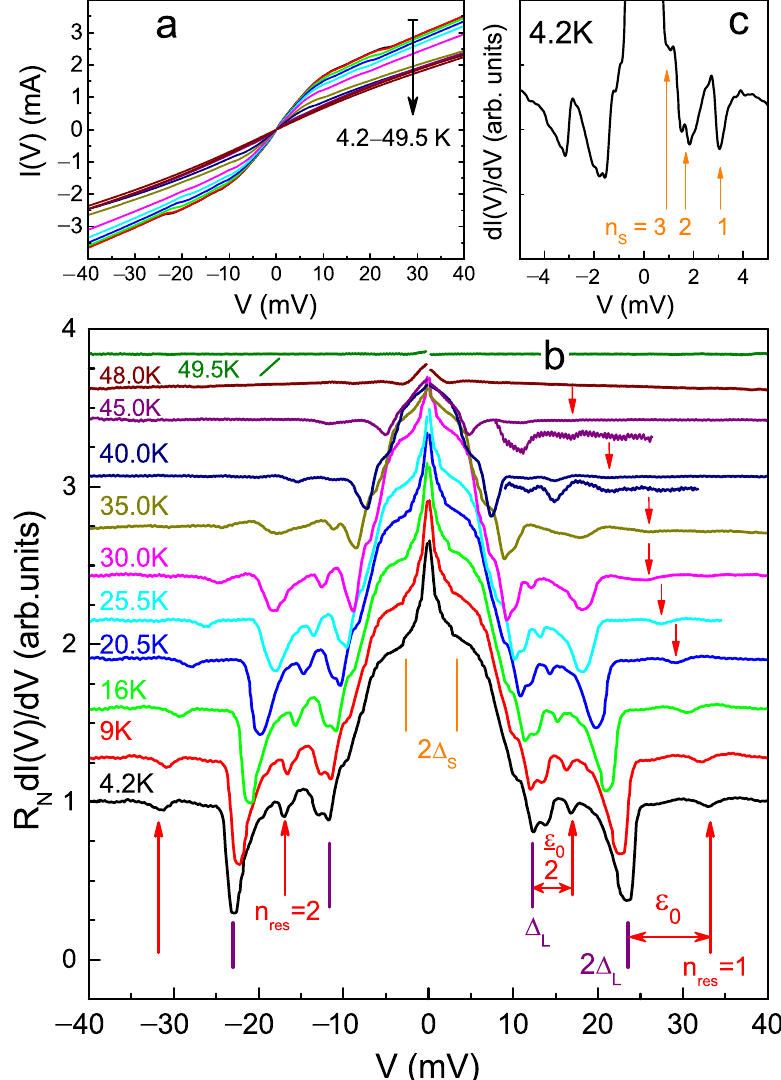
Figure 1. Temperature evolution from 4.2 K till the local critical temperature T local c ≈ 49K of current- voltage characteristic ( a ) and dynamic conductance spectrum ( b ) of SnS Andreev junction formed in Gd-1111. Andreev dips for the large superconducting gap ∆ L ( 0 ) ≈ 11.7 meV are pointed to by purple vertical lines, satellite bosonic resonances are marked by red arrows and labels n res = 1, 2, and double arrows indicate the value of the boson energy ε 0 ≈ 10.4 meV at 4.2 K. At 40 K and 45K, vertically zoomed fragments of dI(V)/dV detailing the boson resonances are also shown. dI(V)/dV curves are shifted vertically for clarity. dI ( eV > 2 ∆ L ) / dV → G N = const . Monotonic background was suppressed. ( c ) The low-bias fragment of the dI(V)/dV spectrum at 4.2 K with additional background suppression that details the SGS of the small gap ∆ S ( 0 ) ≈ 1.6meV ( n S = 1, 2, 3 labels). Temperature evolution of the corresponding dynamic conductance is shown in Figure 1b. Note that the spectra for different temperatures are shifted vertically for clarity. In reality, their conductance dI ( eV > 2 ∆ L ) / dV tends to the normal-state G N , which is nearly constant with the variation of temperature that also favors the ballistic regime. The spectrum measured at 49.5 K becomes flat, thus determining the local critical temperature ≈ 49 K that corresponds to the transition to the normal state of the of the junction T local c contact area. In the spectrum measured at 4.2 K, the position of clear dips located at | eV | ≈ 23.2 meV and | eV | ≈ 11.8 meV (purple vertical dashes in Figure 1b) determine